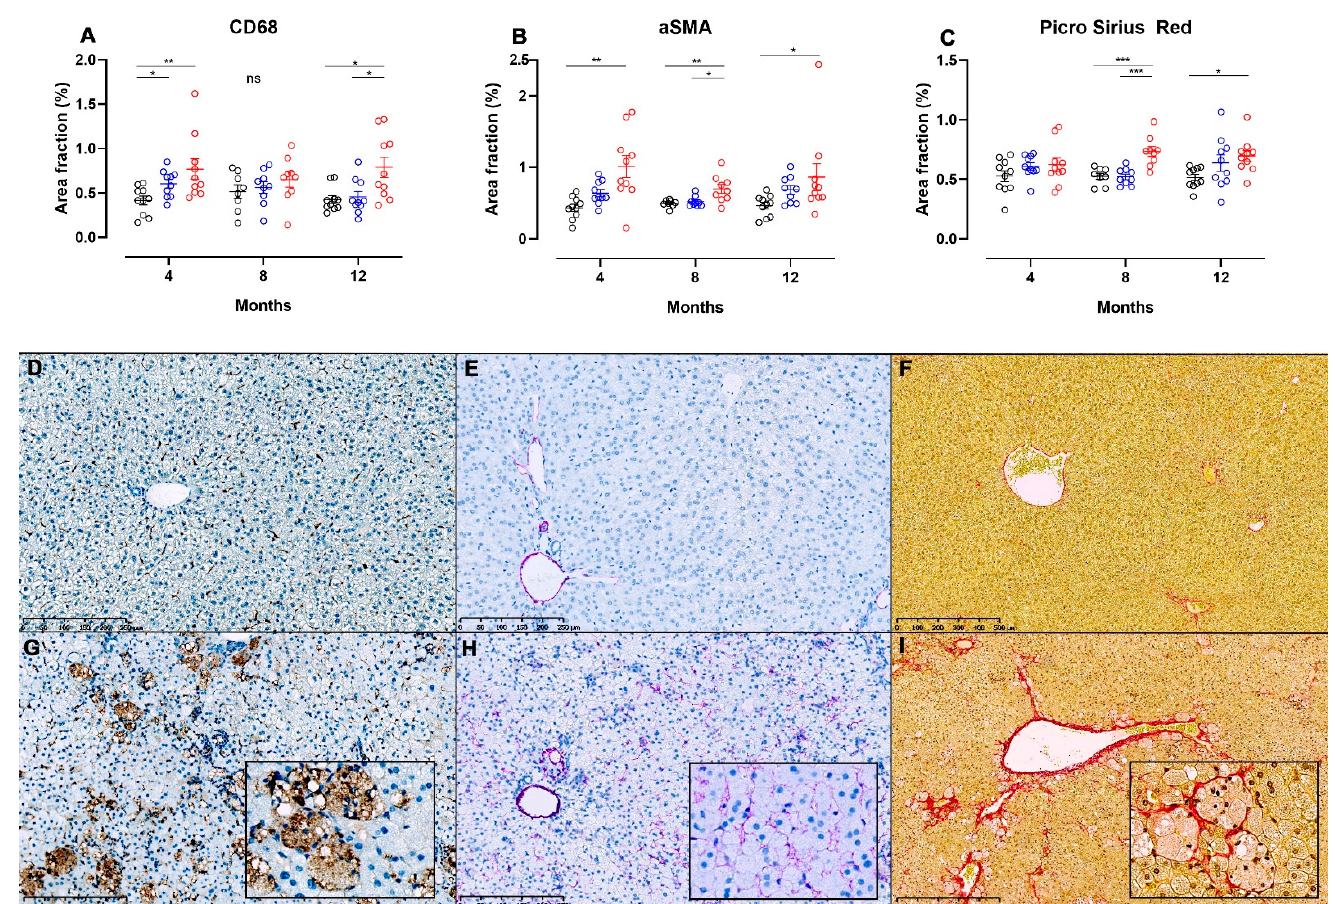
Figure 6. Image analysis of liver sections from NASH- or control diet-fed Syrian hamsters stained for detection of hepatic inflammation, stellate cell activation and fibrosis. Area fractions of CD68+ ( A ) and α -SMA+ ( B ) cells from image analysis of IHC-processed liver sections in chow, CTRL and NASH-fed hamsters at four, eight and 12 months. ( C ) Area fractions of PSR+ staining in chow, CTRL and NASH-fed hamsters at four, eight and 12 months. Black circles indicate chow-fed hamsters, blue circles indicate CTRL-fed hamsters, red circles indicate NASH-fed hamsters. *, **, *** indicate p < 0.05, p < 0.01, and p < 0.001 between groups. ( D – I ) Liver sections showing differences in positive staining of cells/fibres in CD68-, α SMA- and PSR-stained sections of liver from chow (middle row, D – F ) and NASH-fed hamsters ( G – I ) at 12 months. Inserts in ( G – I ) are magnifications (20 × ) of ( G – I